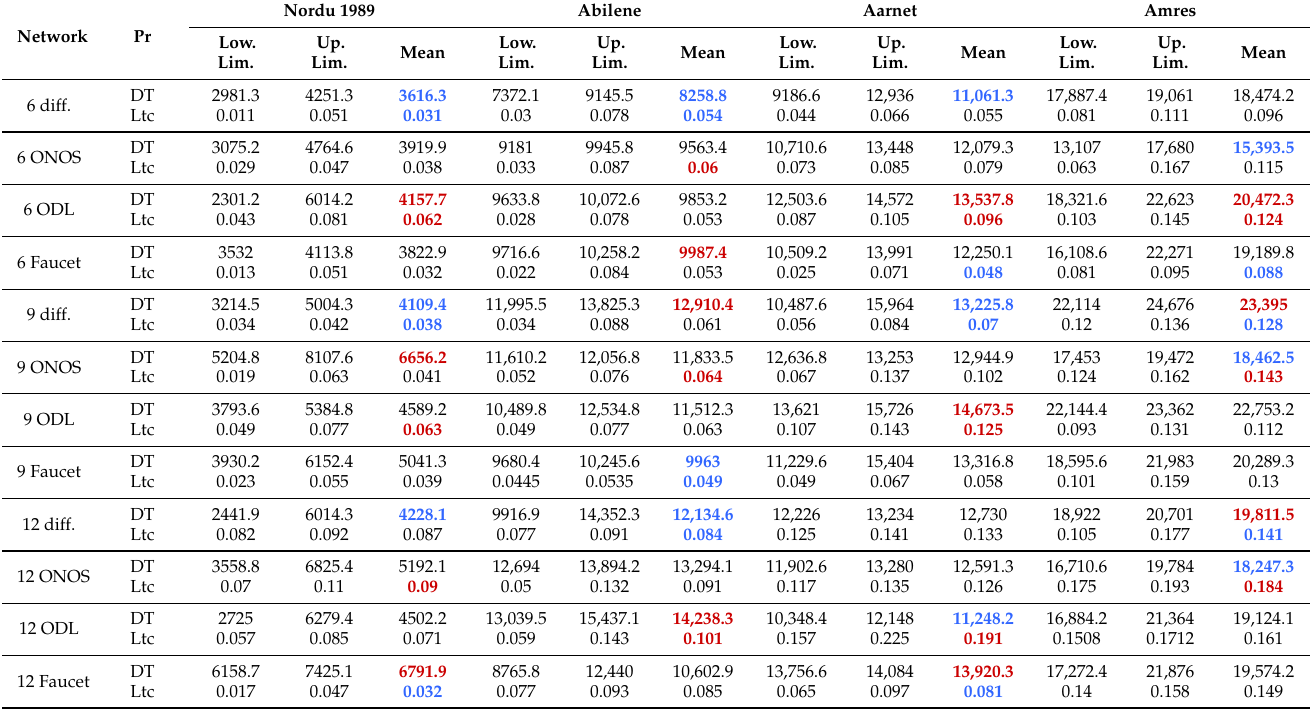
Table 2. Communication between multiple controllers. The blue and bold numbers are the best values in networks with the same number of controllers. Similarly, the red and bold numbers are the worst values. Explaination for abbreviations: x is an integer number. Pr: Parameter; DT: Data Transmission (bit); Ltc: Latency (second); Low. Lim.: Lower limit of the confidence interval Up. Lim.: Upper limit of the confidence interval; x diff.: x/3 ONOS, x/3 ODL, and x/3 Faucet (using SINA). x ONOS Controllers; x ODL Controllers; x Faucet Controllers: not using